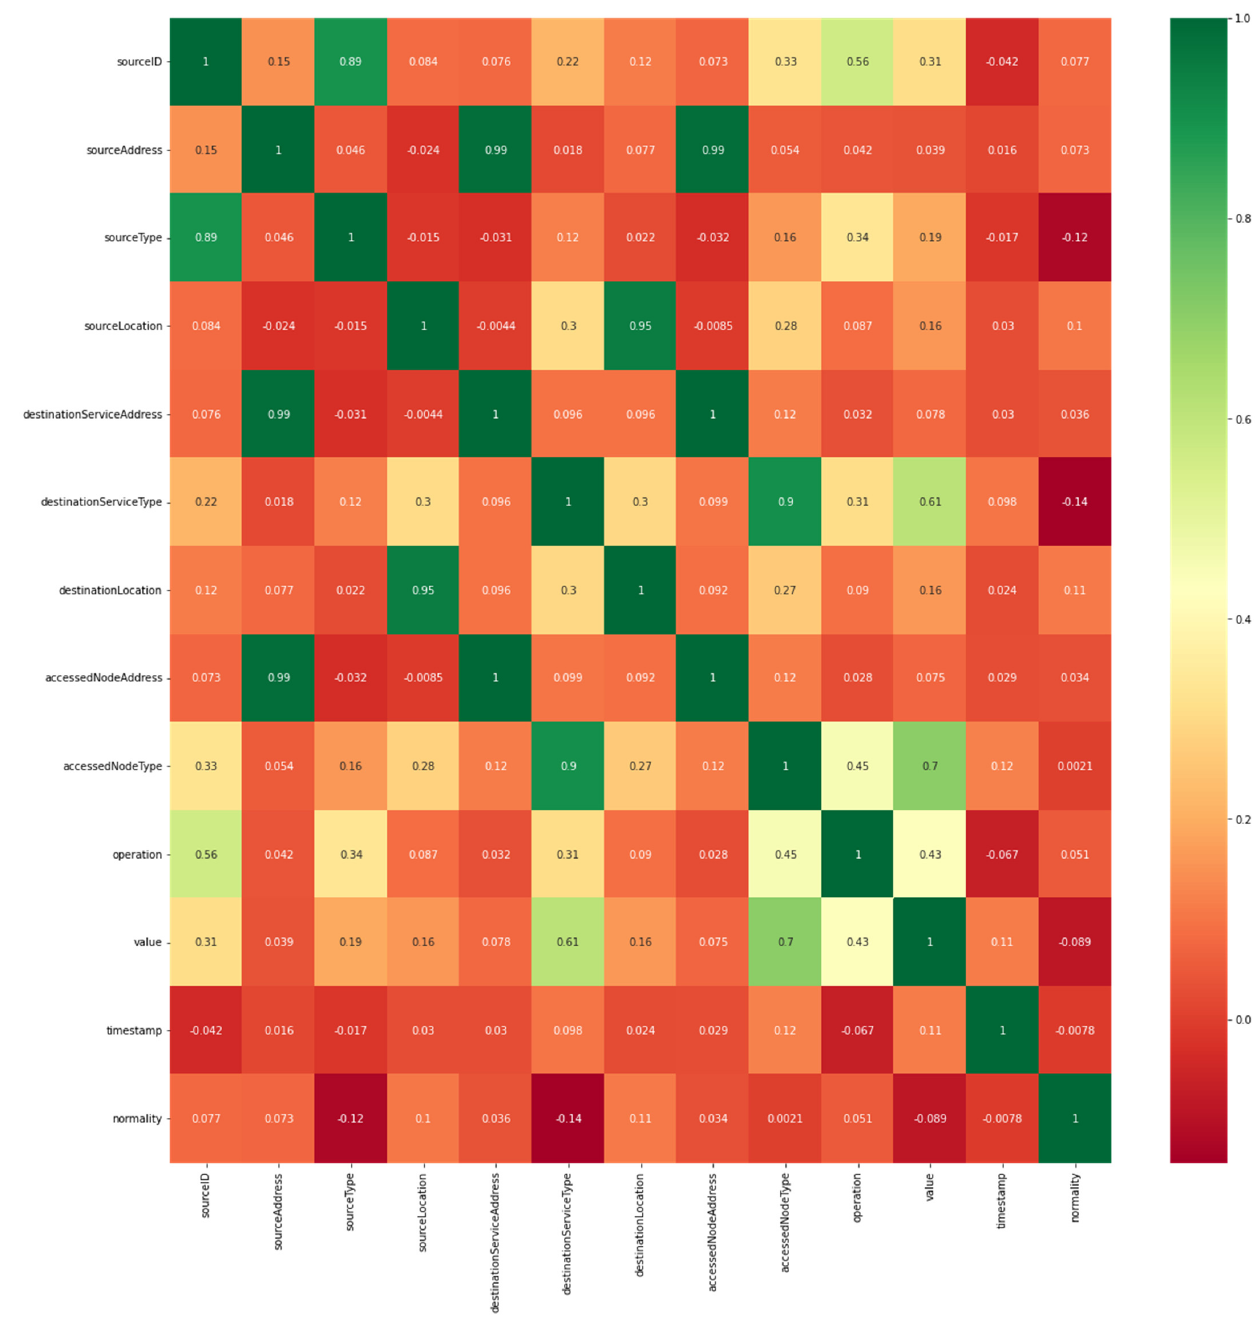
Figure 9. Illustration of the relationship between the dataset features.